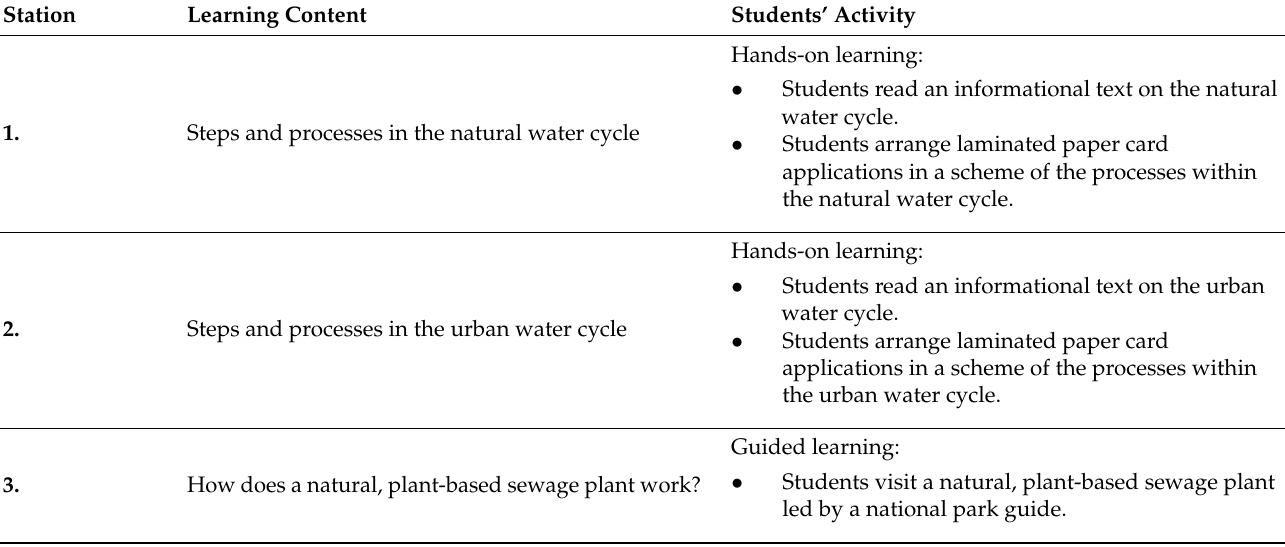
Table 1. Summary of the module content and learning activities at the five